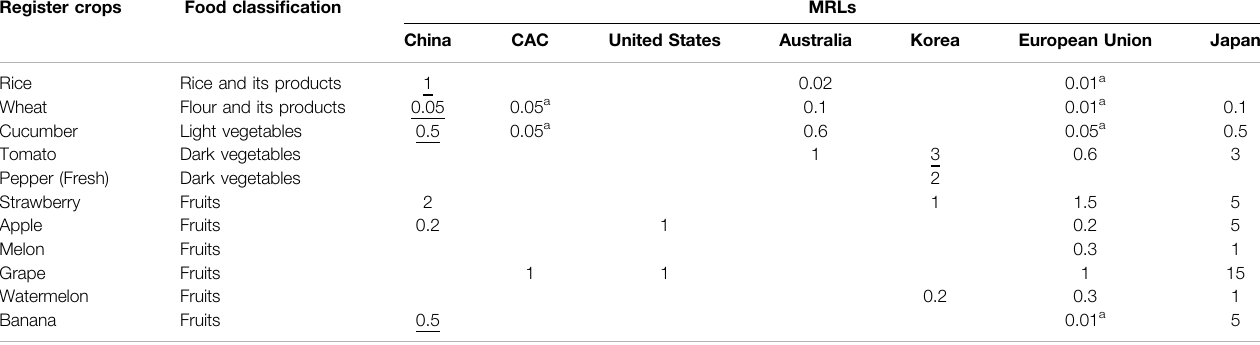
a Represents the temporary limit.